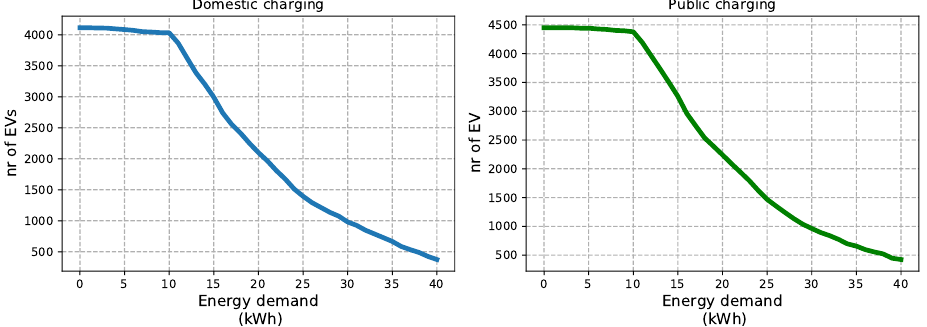
Figure 13. Duration curves of energy demand for domestic and public charging in Scenario